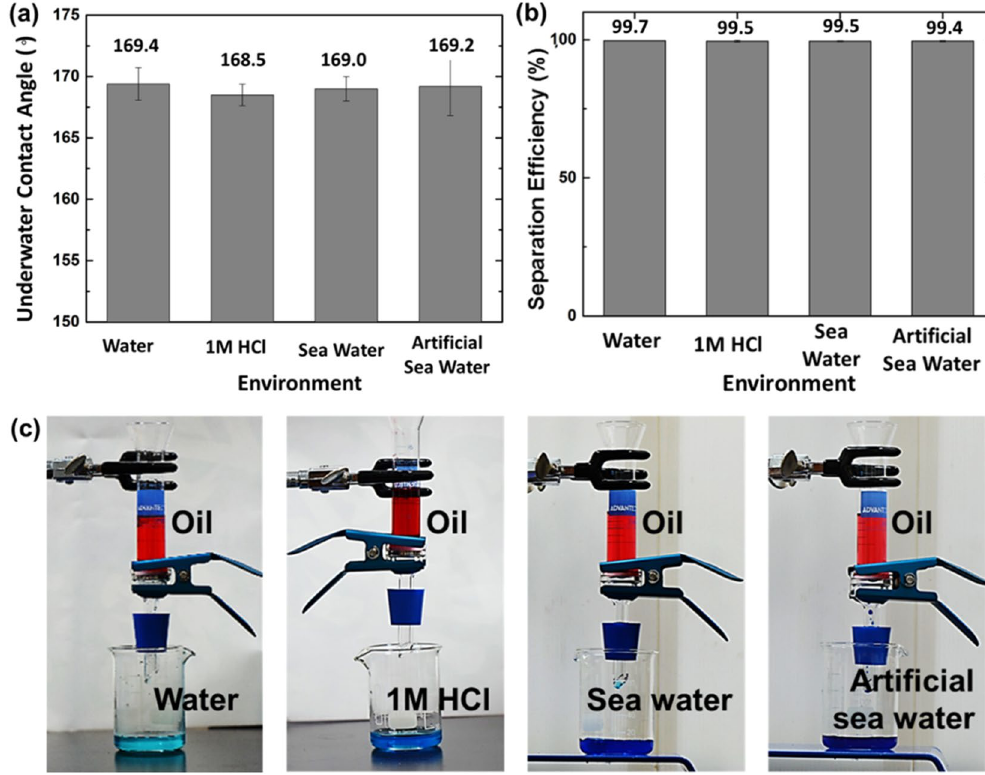
Figure 4. ( a ) The oil contact angle tested under different environments. The plates (cooling rate: 5 °C min − 1 ) show superoleophobicity in pure water, 1 M HCl solution, sea water and artificial sea water. ( b ) The free oil/ water separation efficiencies tested under different environments (V oil = 10 mL, V liquid = 10 mL) and ( c ) the photograph of the separation